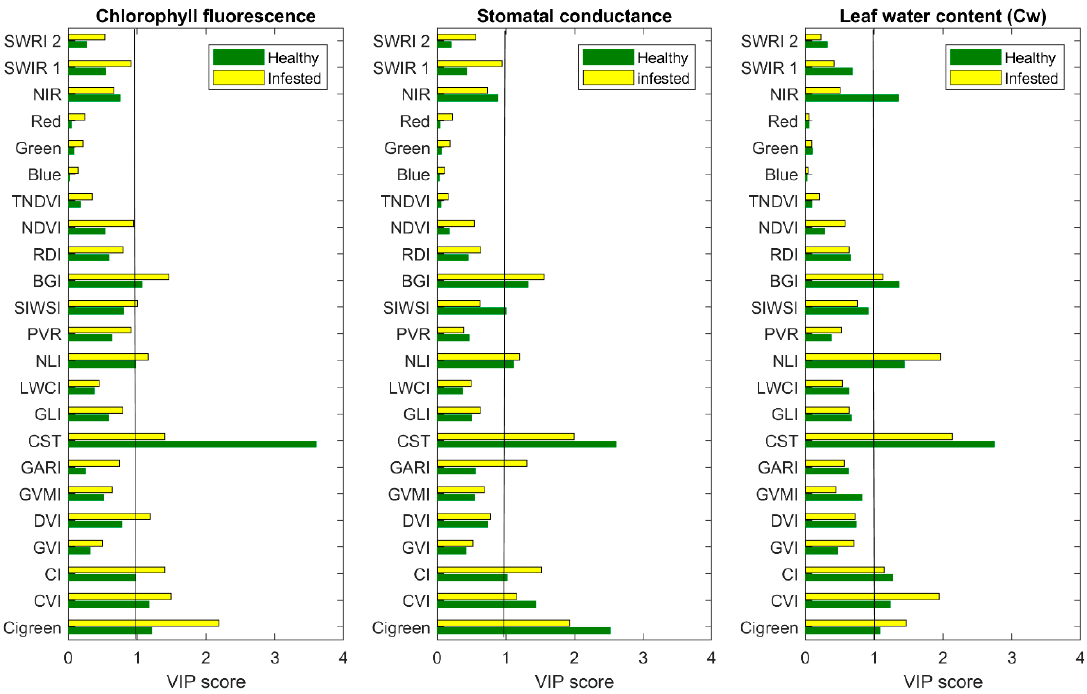
Figure 5. PLSR variable importance in the projection (VIP) for predictor (CST and SVIs) and response variables (measured leaf traits) in the Bavarian Forest National Park, July 2016 (the vertical black line represents VIP ≥